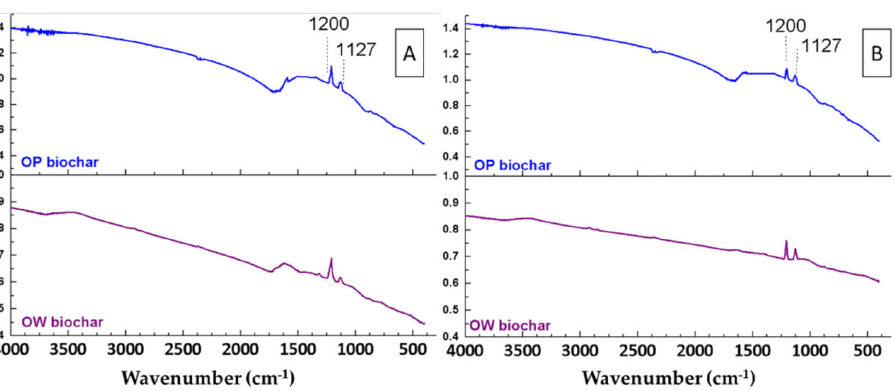
Figure 8. FTIR spectra of orange waste (OW) and orange pruning (OP) biochars after their use for sulphur removal from waste cooking oil. ( A ) Biochars that achieved the highest sulphur removal. ( B ) Biochars that achieved the lowest sulphur